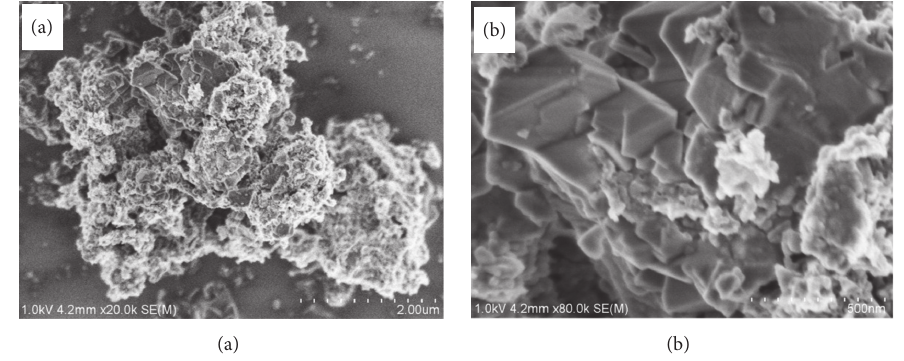
Figure 3: SEM images of the composite material.